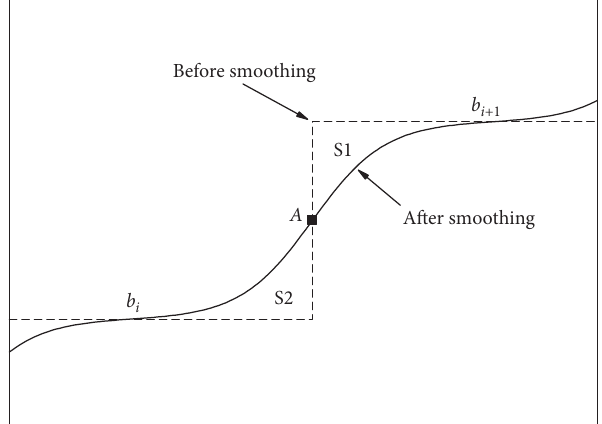
Figure 9: Comparison of differential equations.